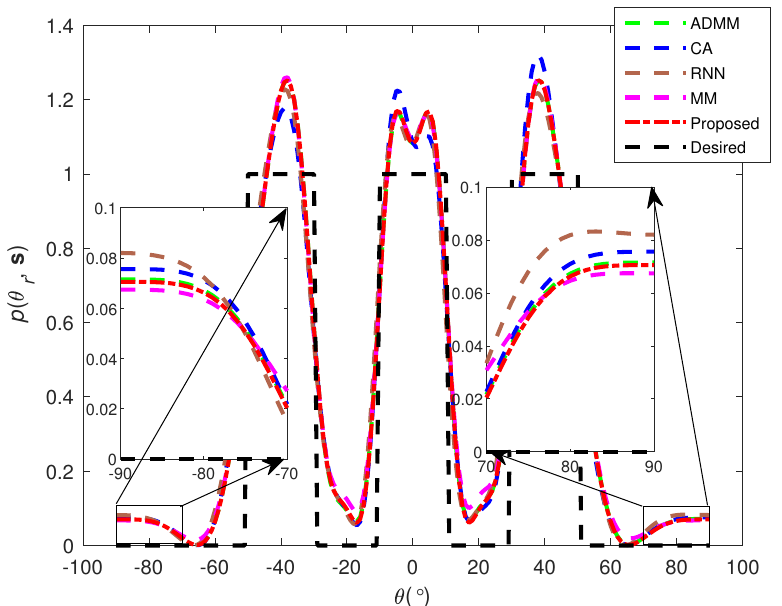
Figure 3. The beampattern matching comparison between different methods when considering Case 2 as the desired beampattern.